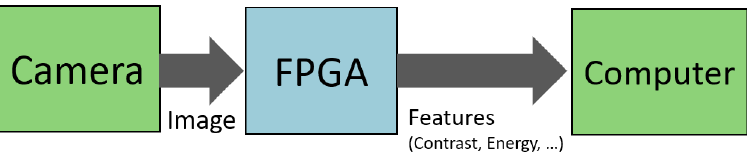
Figure 12. Hardware integration